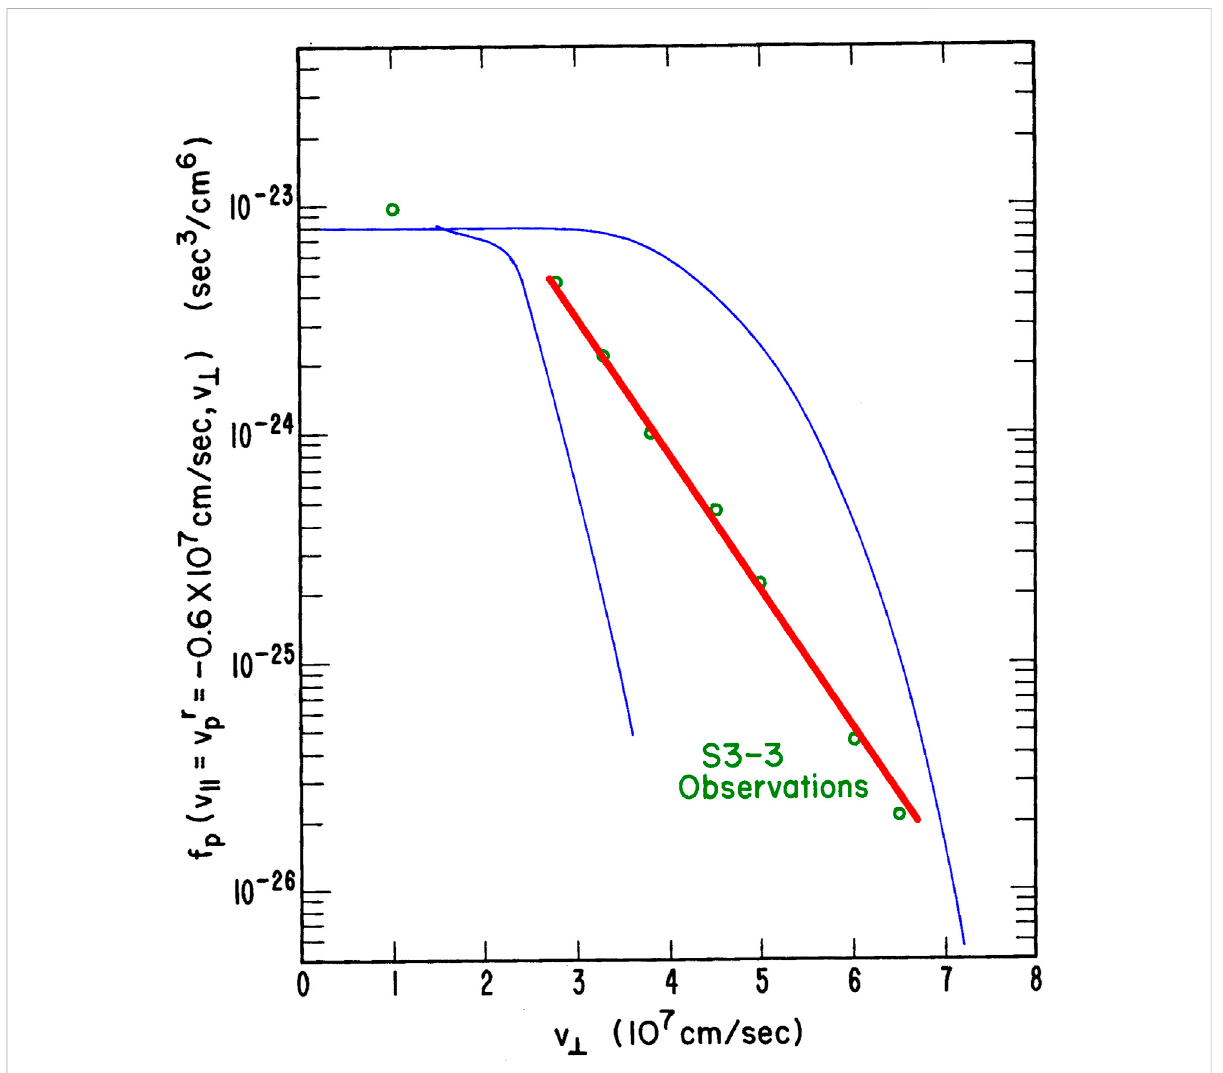
FIGURE 2 Comparison of experimentally measured conic type distribution function on S3-3 satellite on 11 October 1976, at 0046:06 UT (points) with the results of modelling. Blue curve show the results (Dusenbery and Lyons, 1981) model, red curve (Antonova, 1983) model (Antonova,